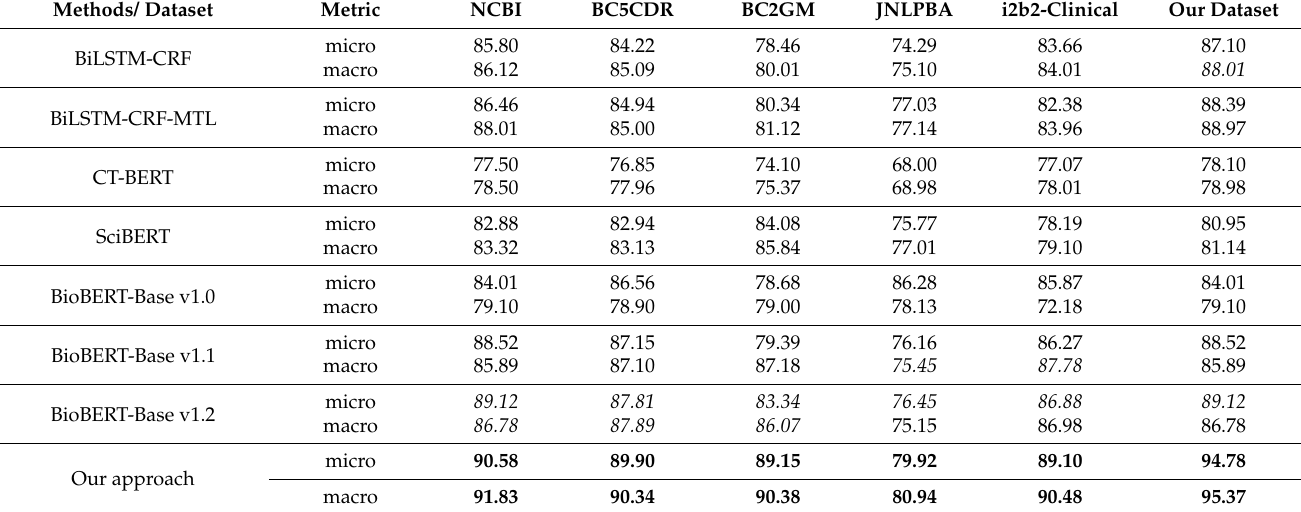
Table 4. Test results using macro-average F1 (macro) and micro-average F1 (micro) scores on all datasets using different methods. The best scores are in bold and the second-best in